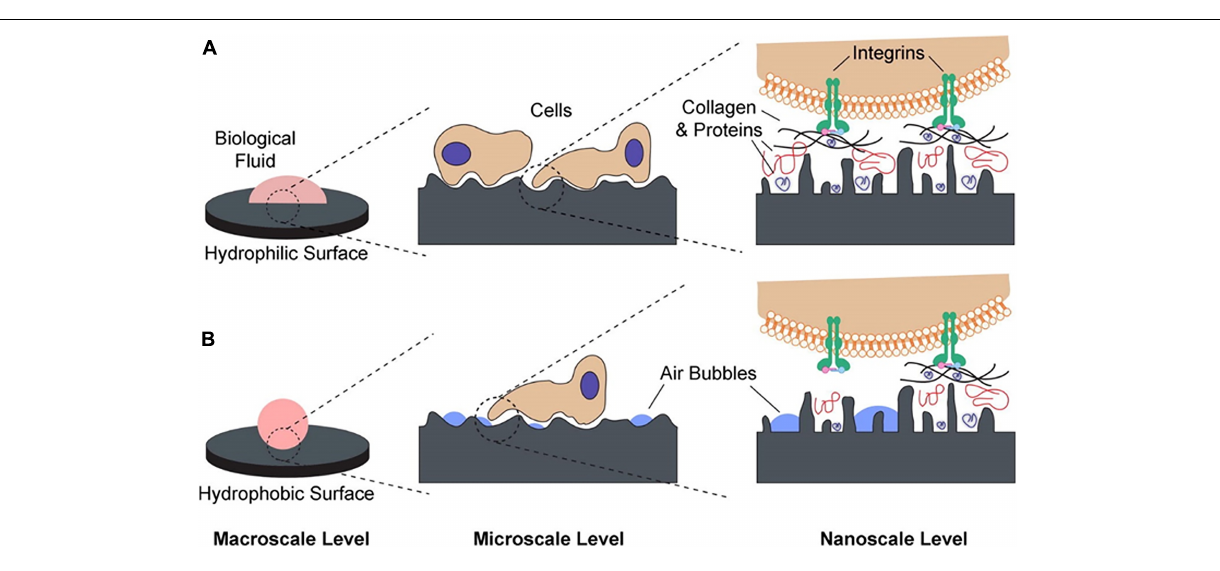
FIGURE 8 | Schematic of the possible interactions at different length scales: (A) hydrophilic surfaces interact closely with biological fluids, allowing normal protein adsorption to the surface and subsequent interactions with cell receptors and (B) hydrophobic surfaces are prone to hydrocarbon contamination, leading to entrapment of air bubbles that can interfere with protein adsorption and cell receptor adhesion/activation (Gittens et al.,